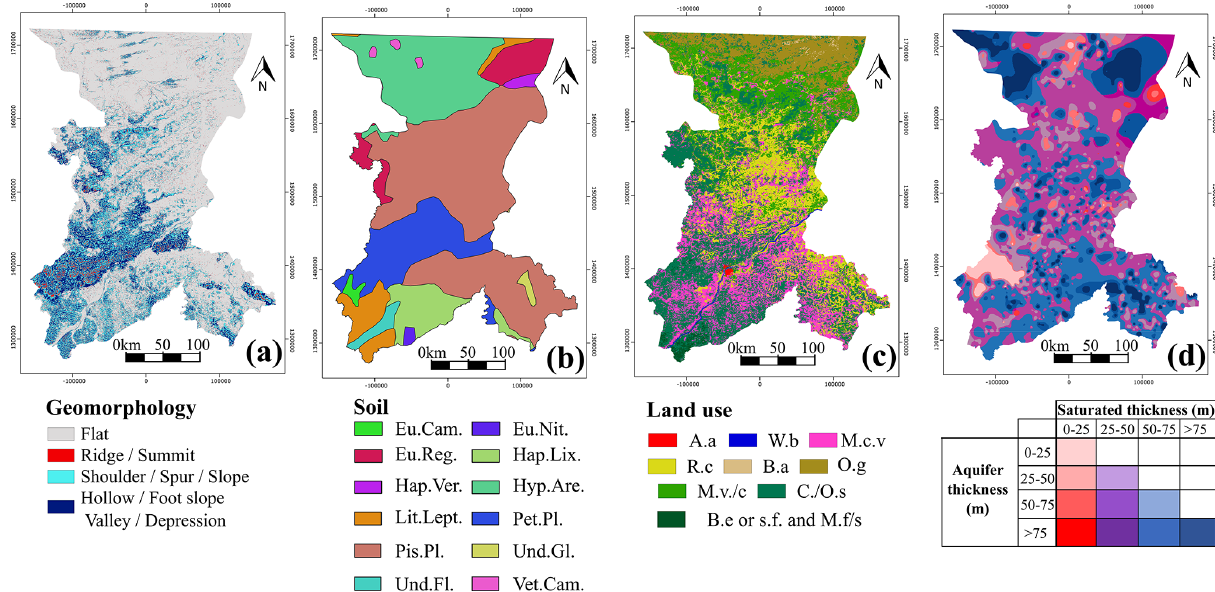
Figure 6. Explanatory variables used to predict the GPM: (a) geomorphology, (b) land use (A.a: artificial areas; W.b: water bodies; M.c.v: mosaic cropland vegetation; R.c: rainfed cropland; B.a: bare areas; O.g: open grassland; M.v./c: mosaic vegetation/cropland; C./O.s: close to open shrubland; B.e or s.f. and M.f/s: broadleaf evergreen or semi-deciduous forest and mosaic forest/shrubland), (c) soil (Eu.Cam.: eutric Cambisols; Eu.Nit.: eutric Nitrisols; Eu.Reg.: eutric Regosols; Hap.Lix.: haplic Lixisols; Hap.Ver.: haplic Vertisols; Hyp.Are.: hypoluvic Arenosols; Lit.Lept.: lithic Leptosols; Pet.Pl.: petric Plinthosols; Pis.Pl.: pisoplinthic Plithosols; Und.Gl.: undifferentiated Gleysols; Und.Fl.: undifferentiated Fluvisols; Vet.Cam.: vertic Cambisols) and (d) expected thickness